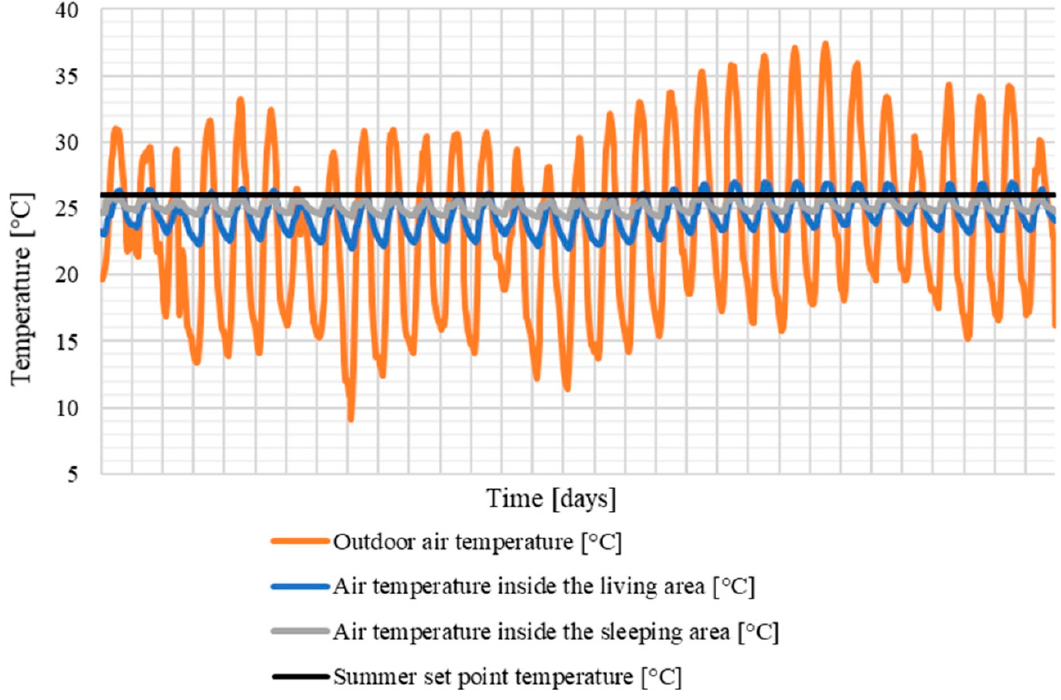
Figure 9. Trend in outdoor air temperatures, inside the living and sleeping areas in